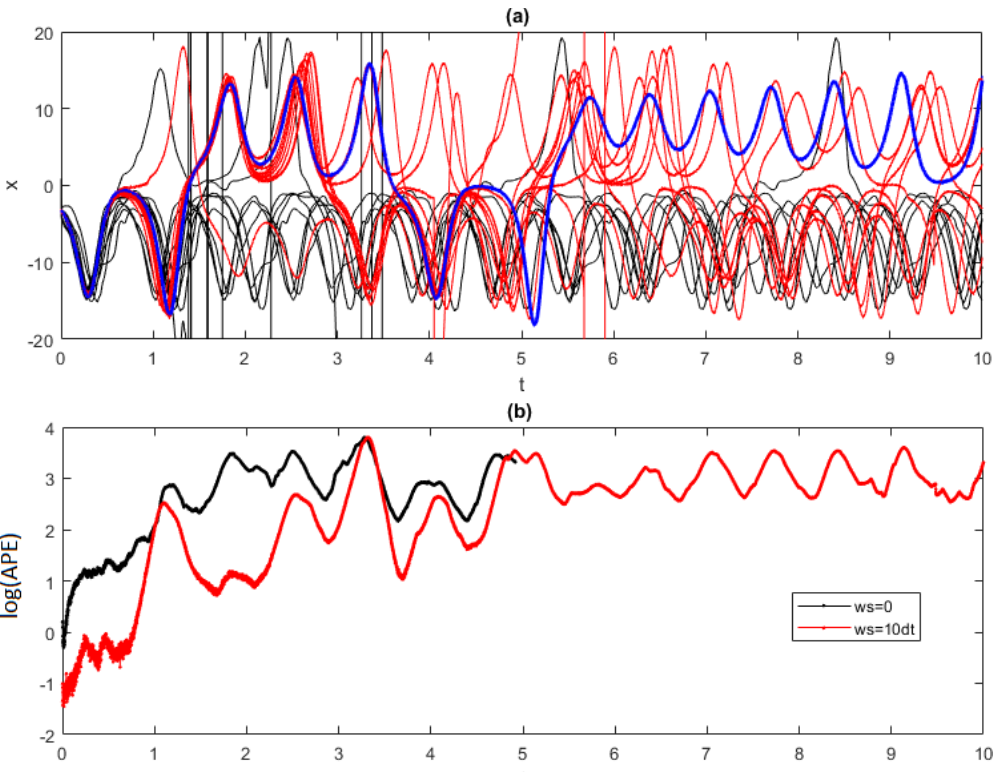
Figure 2. (a) Trajectories predicted using ESN on the Lorenz 1963 attractor for the variable x . The attractor is perturbed with Gaussian noise with variance (cid:15) = 0 . 1. The target trajectory is shown in blue. Ten trajectories obtained without a moving average (black) show an earlier divergence compared to 10 trajectories where the moving average is performed with a window size of w = 10d t = 0 . 01 (red). Panel (b) shows the evolution of the log ( APE ) averaged over the trajectories for the cases with w = 0 . 01 (red) and w = 0 (black). The trajectories are all obtained after training the ESN for the same training set consisting of a trajectory of 10 5 time steps. Each trajectory consists of 10 4 time